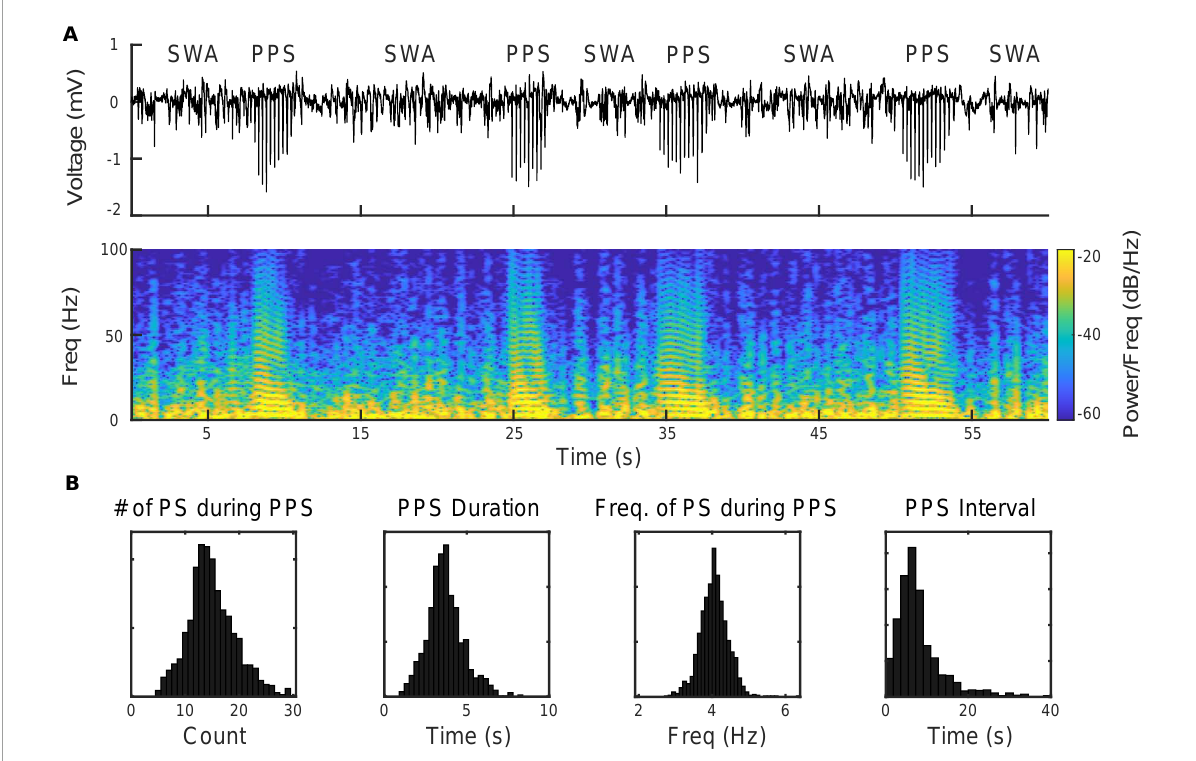
FIGURE5 Alternation between slow-wave activities (SWA) and PPS as the signature pattern of ketamine. (A, top) Wideband signal showing SWA and PPS; (A, bottom) spectrogram of the signal. The horizontal strips during PPS reflect the harmonics of the fundamental frequency of population spikes within PPS. (B) Distributions of number of population spikes (PS) during PPS, PPS duration, frequency of PS during PPS, and PPS-PPS intervals.